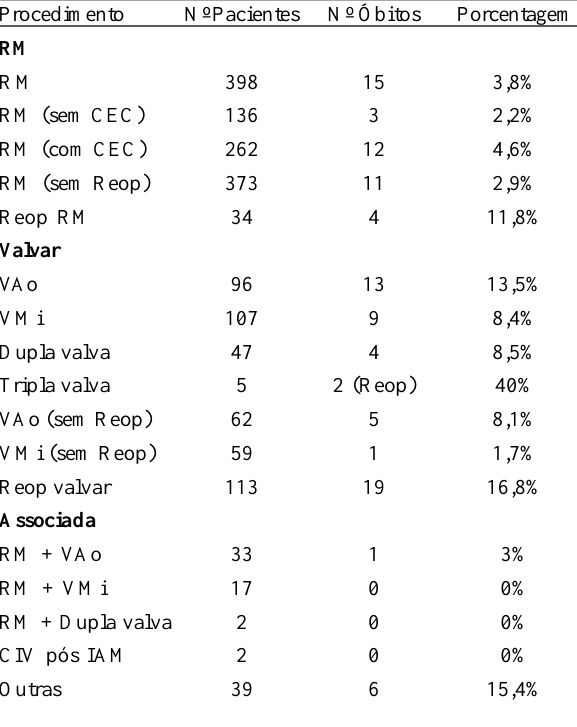
Tabela 1. Mortalidade por tipo de procedimento cirúrgico. Procedimento